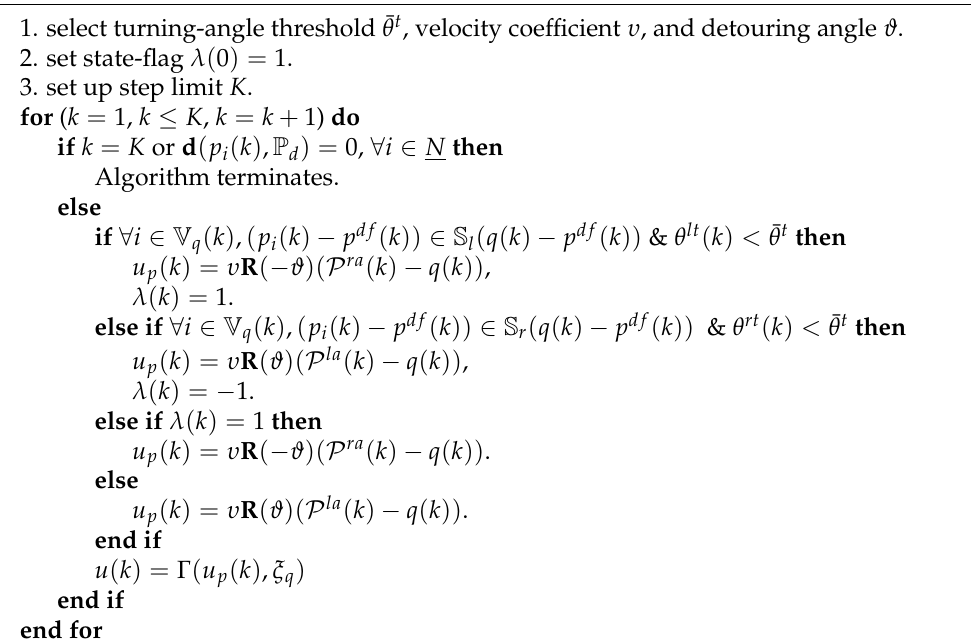
Figure 7. An example illustrating the dynamic far–end mechanism. Algorithm 2 Herding Algorithm With Dynamic Far-end